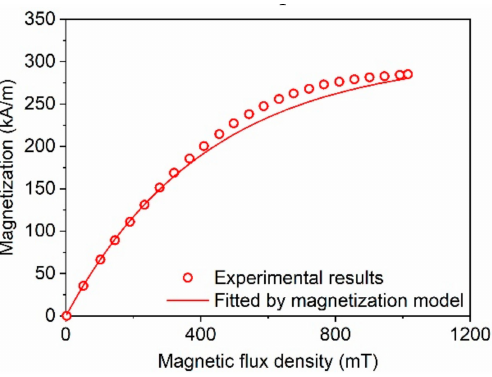
Figure 3. Comparison of the magnetization curves between model calculation and experimental